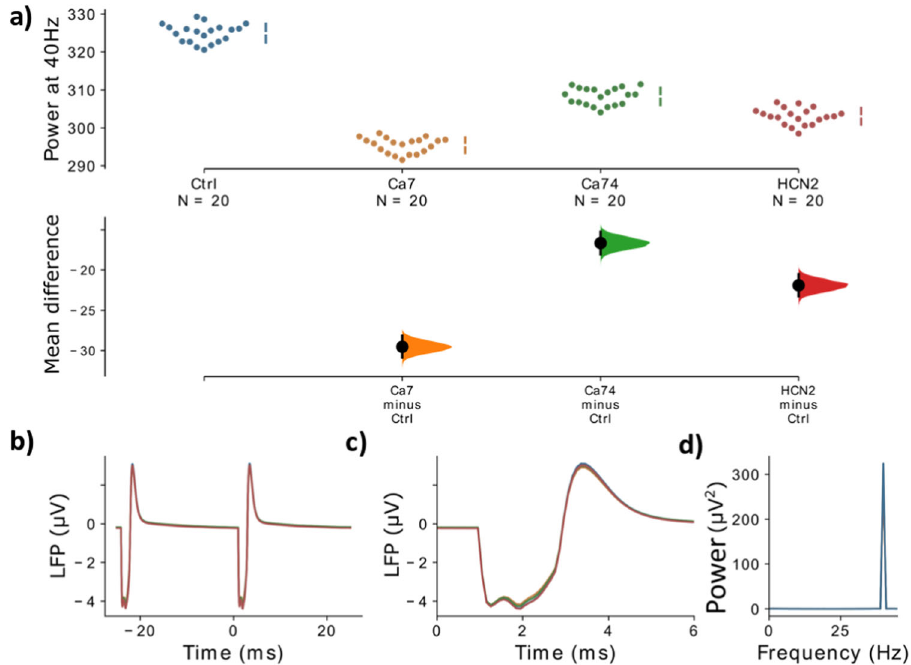
Fig. 3 Comparison of different variants against the control. a The mean difference, i.e. for three comparisons (the Ca 2 + channel model variants, Ca7 and Ca74, and the HCN model variant, HCN1-2, with the strongest gamma reduction) against the shared control are shown in the above Cumming estimation plot. The raw data is plotted on the upper axes. On the lower axes, mean differences are plotted as bootstrap sampling distributions. Each mean difference is depicted as a dot. Each 95% con fi dence interval is indicated by the ends of the vertical error bars. b The simulated LFP signal for the control network (blue), Ca7 (yellow), Ca74 (green), and HCN1-2 (red) is shown, averaged over two consecutive gamma cycles. c The two signals from b are presented with a zoom into the narrow time frame after the stimulus arrives at 0 ms. d The power spectral density (PSD) for the LFP signals from b . Note that in b – d the LFP signal is fi rst averaged over all ‘ subjects ’ and ‘ trials ’